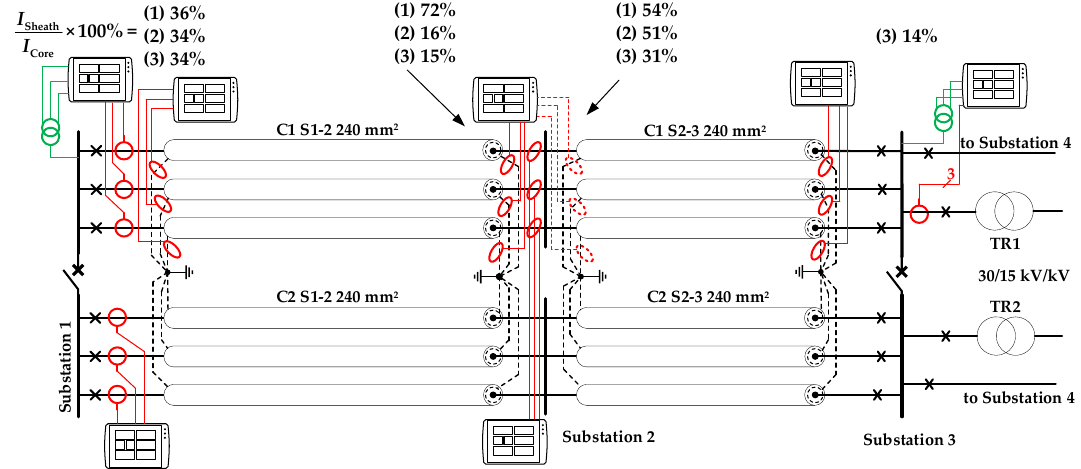
Figure 8. Sheaths currents measured at Substation 2 in direction to Substation 3. Actual operating system of sheaths (Sh1). Operation only with the analyzed line.